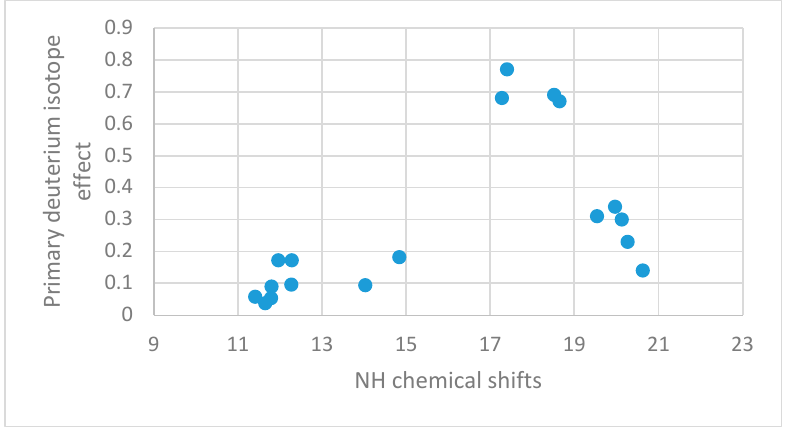
Figure 24. Plot of primary deuterium isotope effects vs. NH chemical shifts. Data from [56,85].